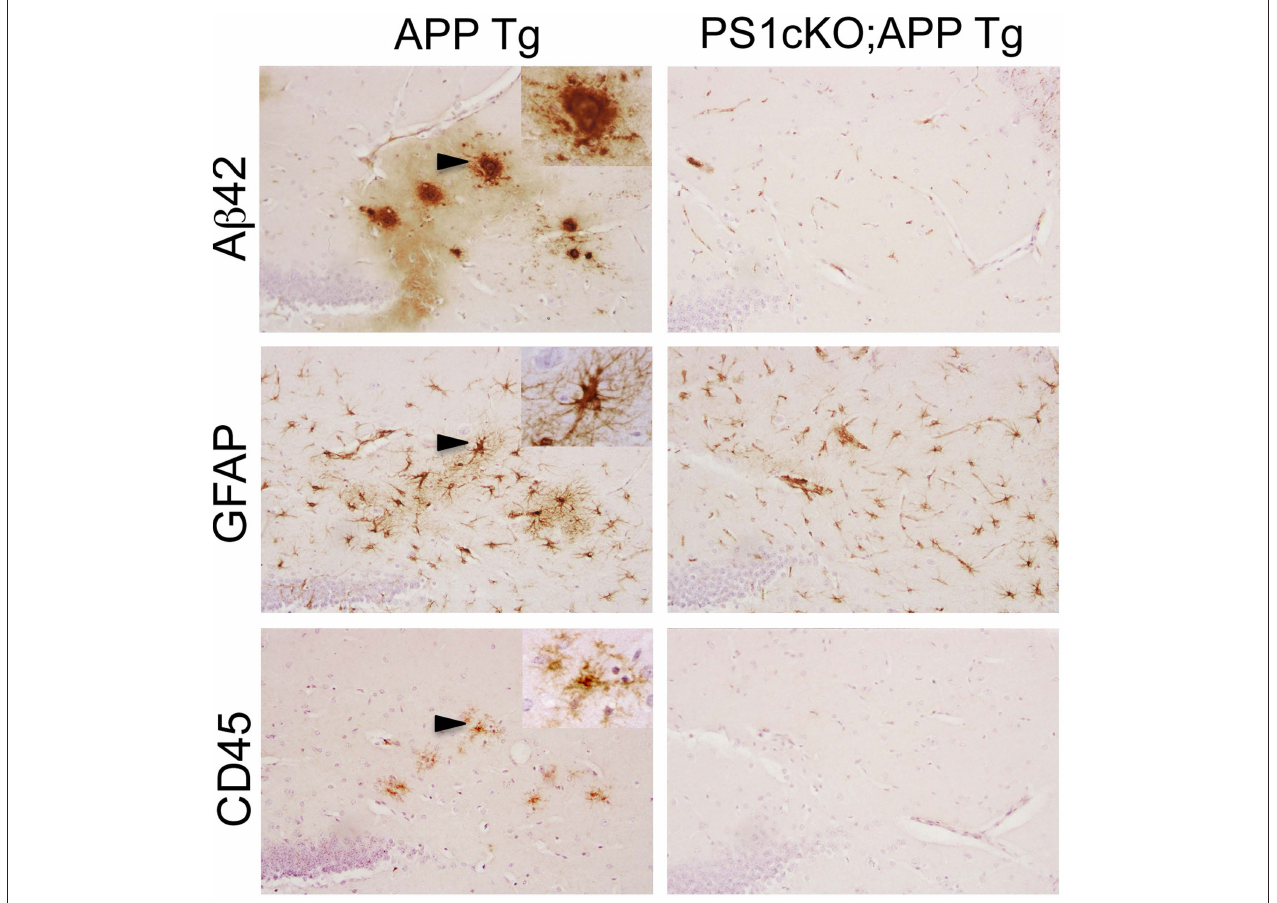
FIgure  | PS inactivation reduces brain inflammation in APP transgenic mice. The images show consecutive serial brain sections of 6 month-old APP (APP ; J20) and PS1cKO;APP transgenic (Tg) mice Sw,Ind stained with antibodies against A β 42, GFAP and CD45. Reactive astrocytes labeled with a GFAP antibody and activated microglia stained with